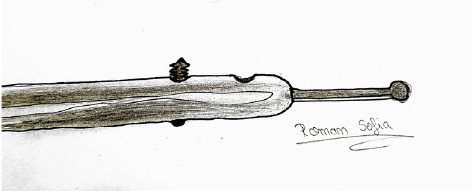
Figure 5. Screw of 3.5 mm inserted through the nail distal locking hole.